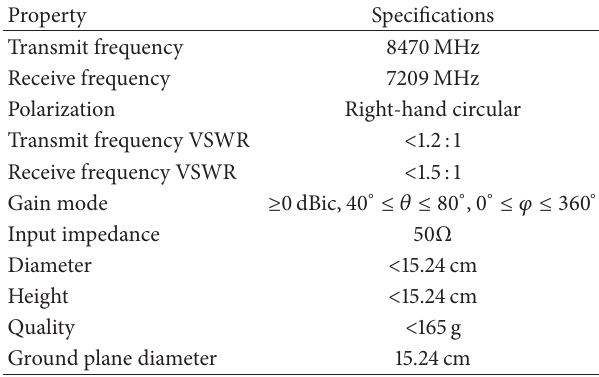
Table 4: Antenna design specifications of NASA ST5